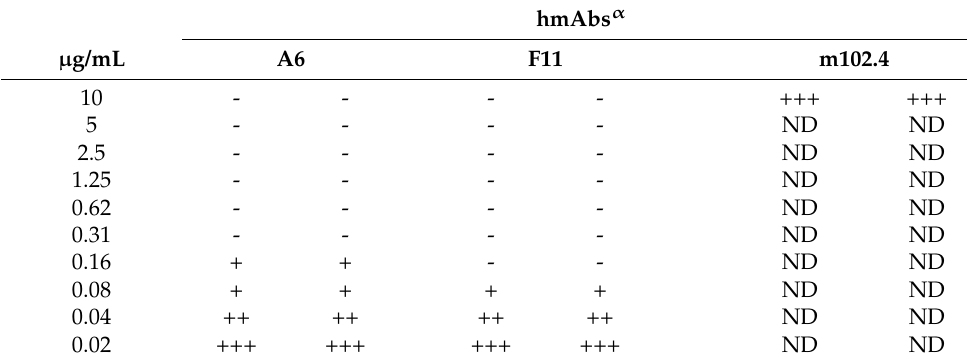
Table 1. Neutralization of rABLVp-GFP infection by hmAbs A6 and